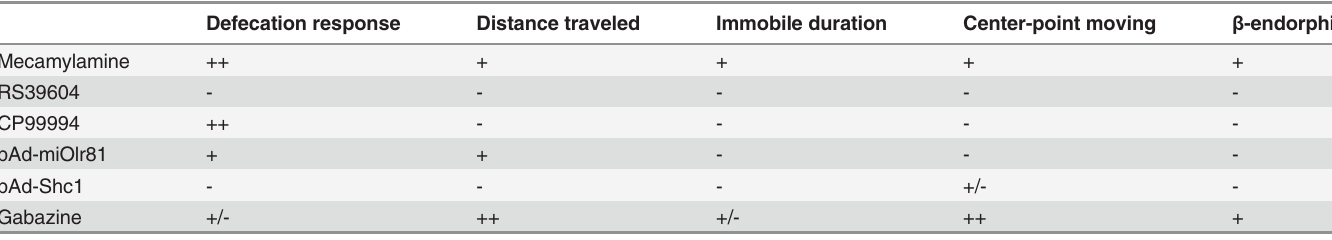
Table 3. Summary of Elvax-implantation effects on MSS